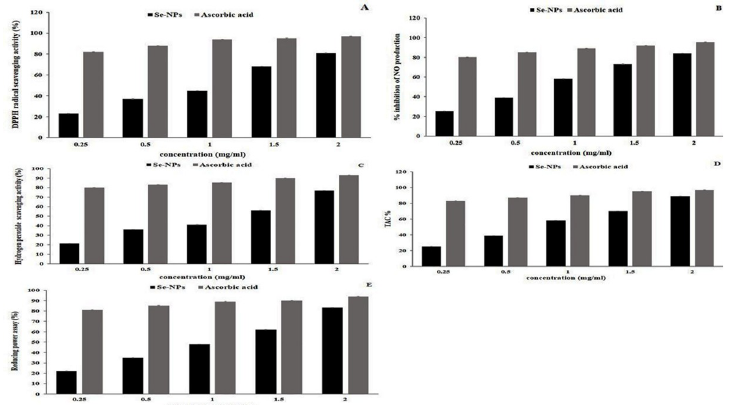
Fig 3. Dose-dependent antioxidant activities of Se-NPs. The antioxidant activity was measured by five different assays for each parameter. A: DPPH radical scavenging activity, B: NO free radical scavenging activity, C: Hydrogen peroxide scavenging activity, D: total antioxidant activity, E: Reducing Power assay.